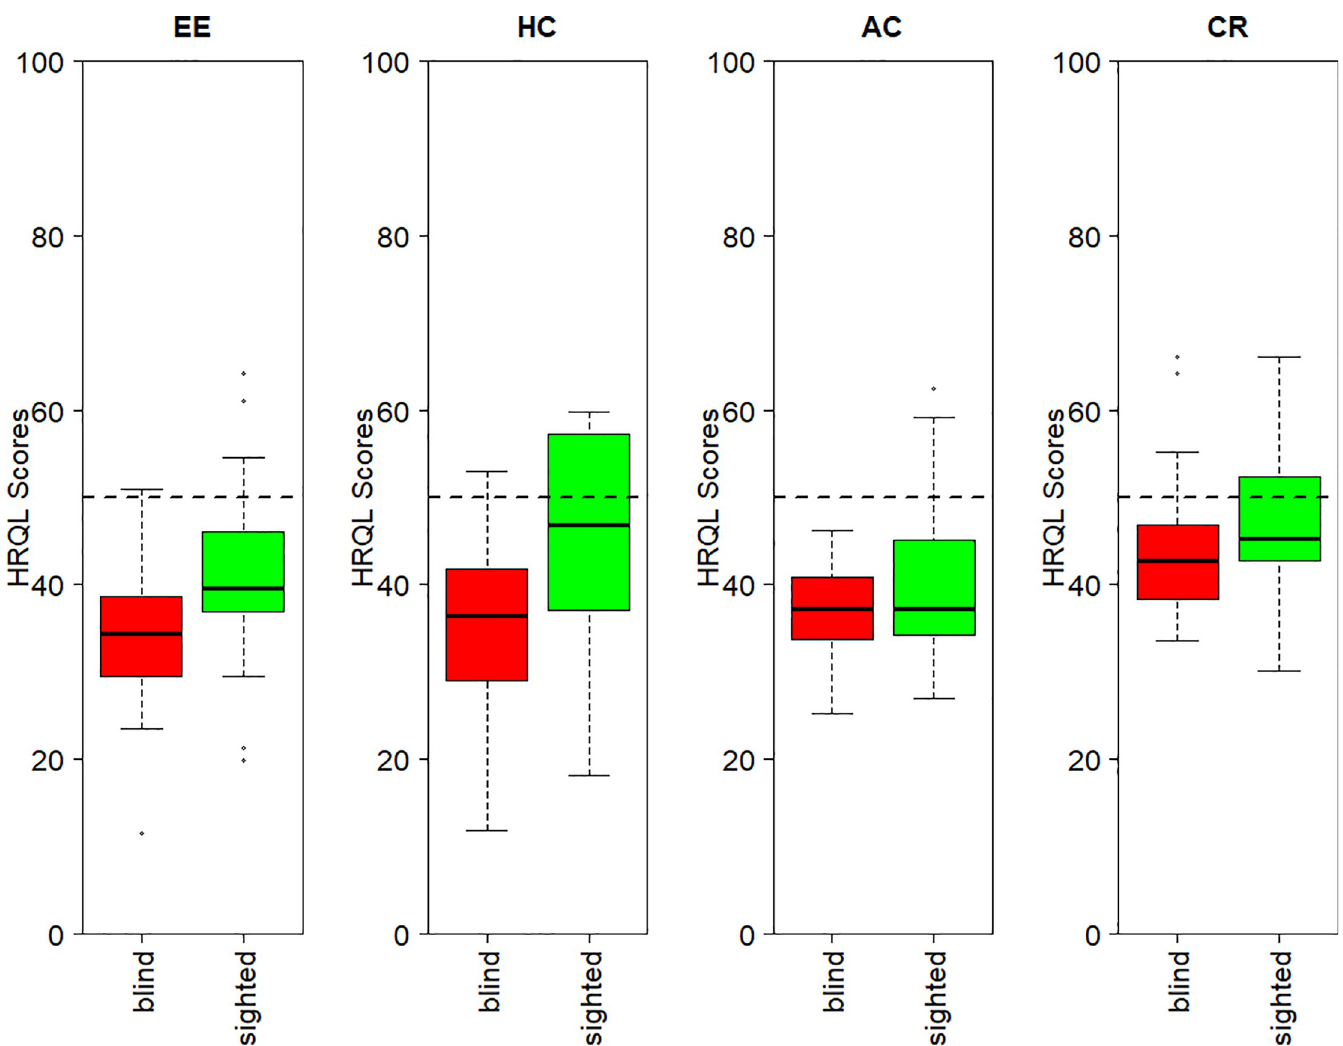
Fig 4. Boxplots of HRQL scores in 4 domains for 2 groups of dogs with ocular disease, one blind and the other with functional vision. A score of 50 represents that of the average healthy dog according to